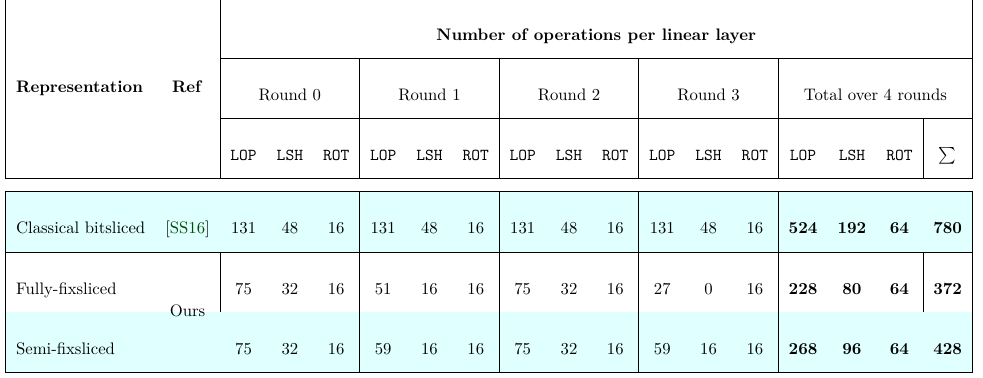
Table 1: Number of operations required to compute the AES linear layer over 4 rounds when processing 2 blocks in parallel, for different representations. LOP , LSH and ROT refer to logical operations, logical shifts and rotations,